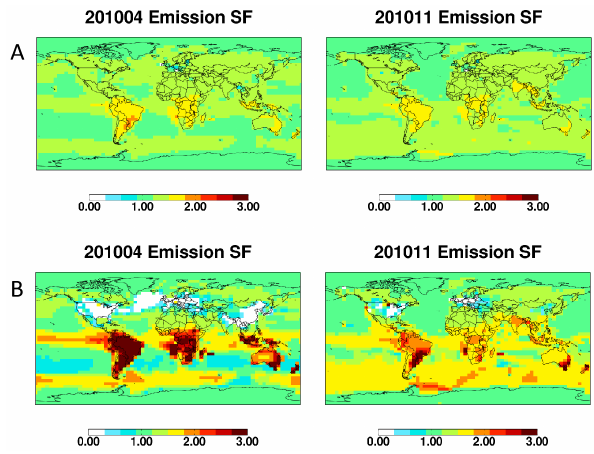
Figure 11. Inversion of N 2 O emissions based on real surface ob- servations. A posteriori emission scaling factors are shown for two different prior error assumptions: (a) 100% a priori error and hor- izontal covariance length scales of 500 and 1000km for land and ocean emissions, respectively; and (b) no penalty term in the cost